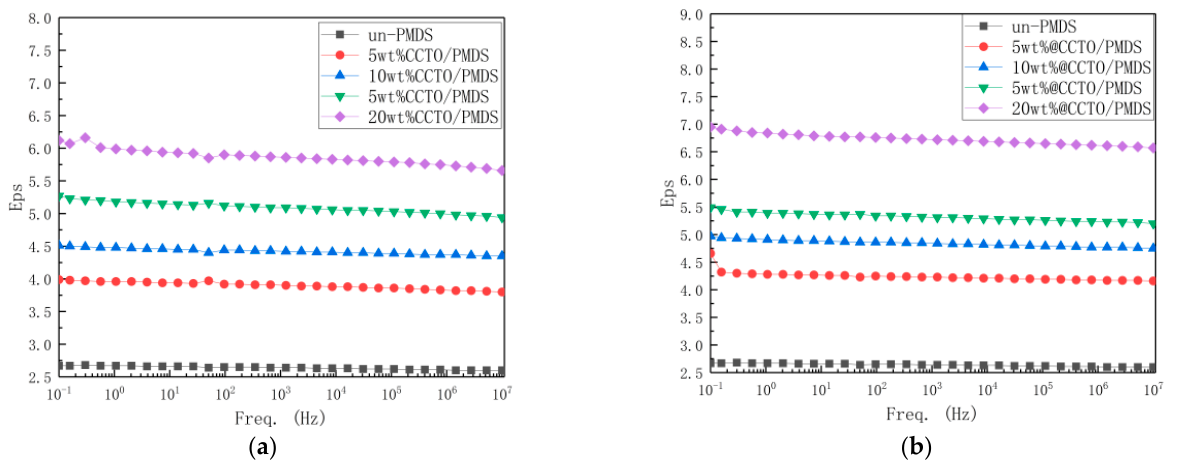
Figure 11. ( a ) The broadband dielectric spectroscopy of CCTO/PDMS composite; ( b ) The broadband dielectric spectroscopy of modified CCTO/PDMS composite.